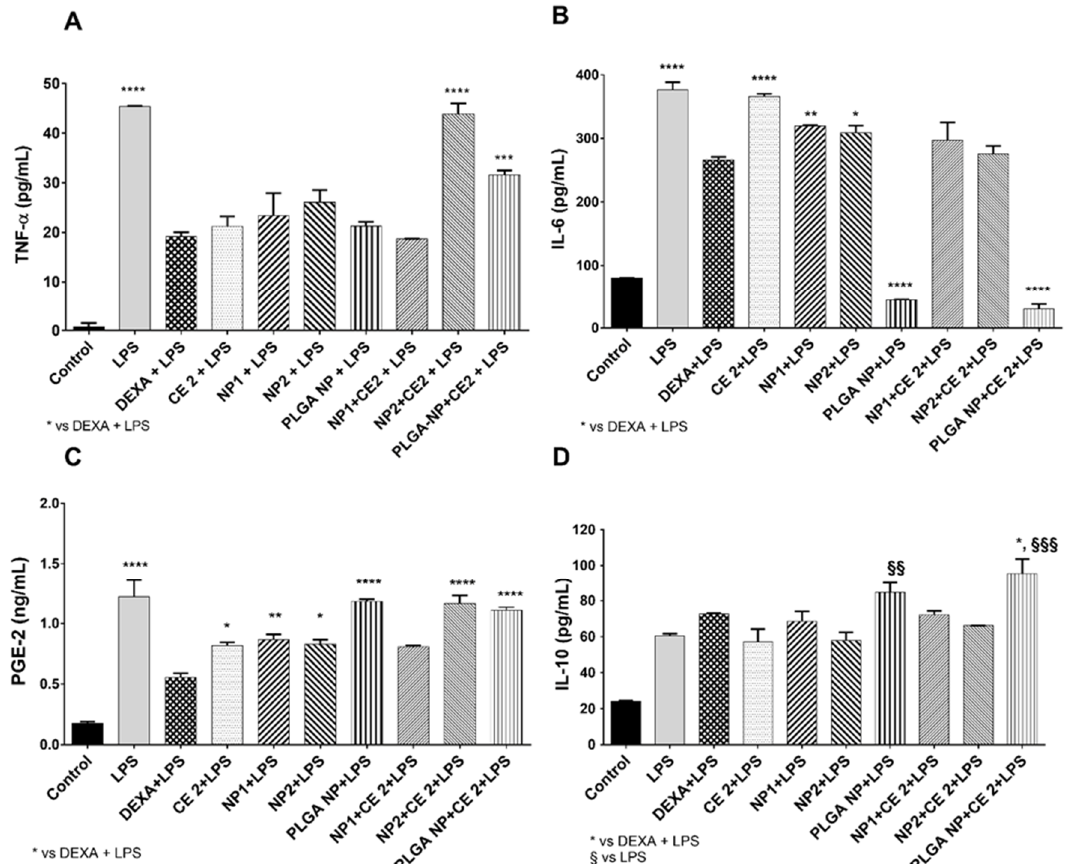
Figure 3. Anti-inflammatory e ff ect of loaded nanoparticles. HUVEC were treated with empty or CE-loaded NPs (NP1:QA-Ch-NP; NP2:QA-Ch-S-pro-NP; and PLGA NP) with 2 µ g / mL GAE of CE (CE 2) or DEXA (5 µ g / mL) for 2 h and with LPS (10 µ g / mL) for 24 h. Evaluation of the inflammatory cytokines secretion: ( A ) TNF- α , ( B ) IL-6, ( C ) PGE2, ( D ) IL-10. Data are expressed as mean ± SD of at least three independent experiments in triplicate. * p vs. DEXA + LPS and § p vs. LPS. 0.0332(**), 0.0021(***), < 0.0001(****) and 0.0332(§§),